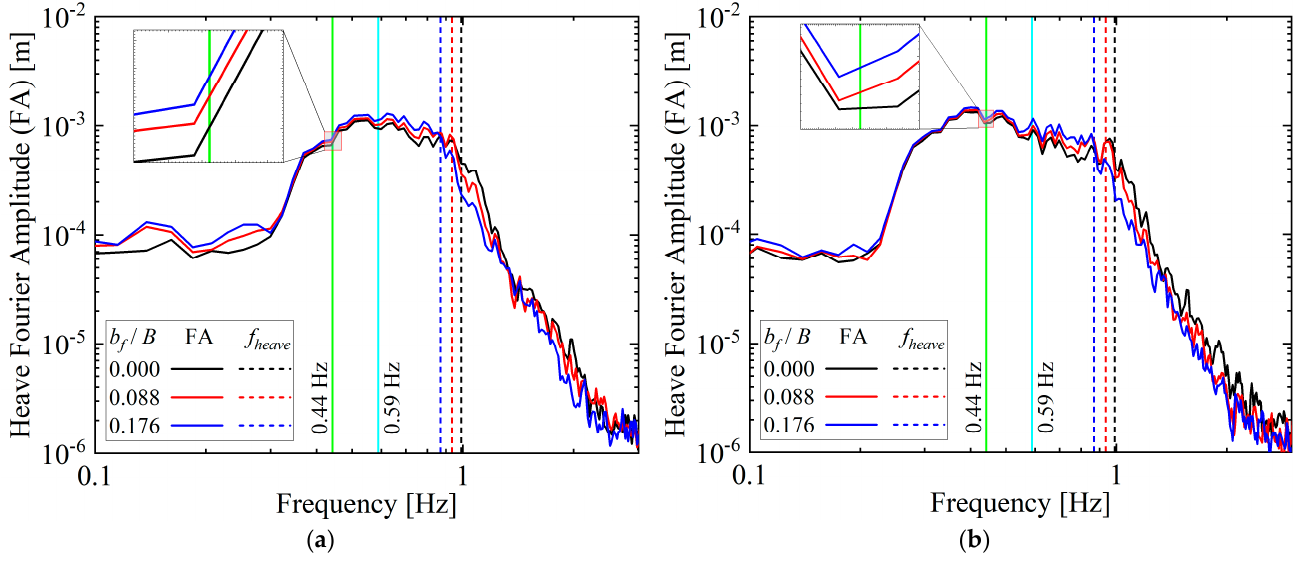
Figure 20. Fourier amplitude (FA) of the heave for the irregular waves: ( a ) f s = 0.59 Hz; ( b ) f s = 0.44 Hz.